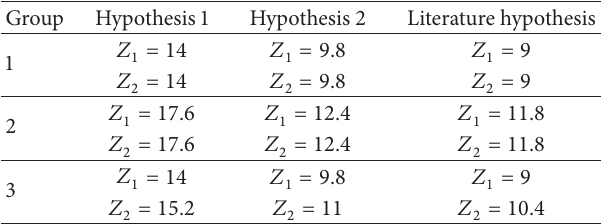
Table 3: Comparative study of optimal threshold inventory